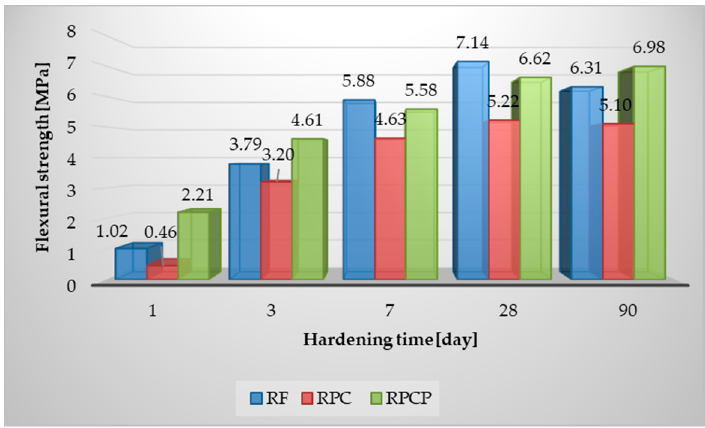
Figure 6. Development of flexural strength of tested specimens over time up to 90 days.